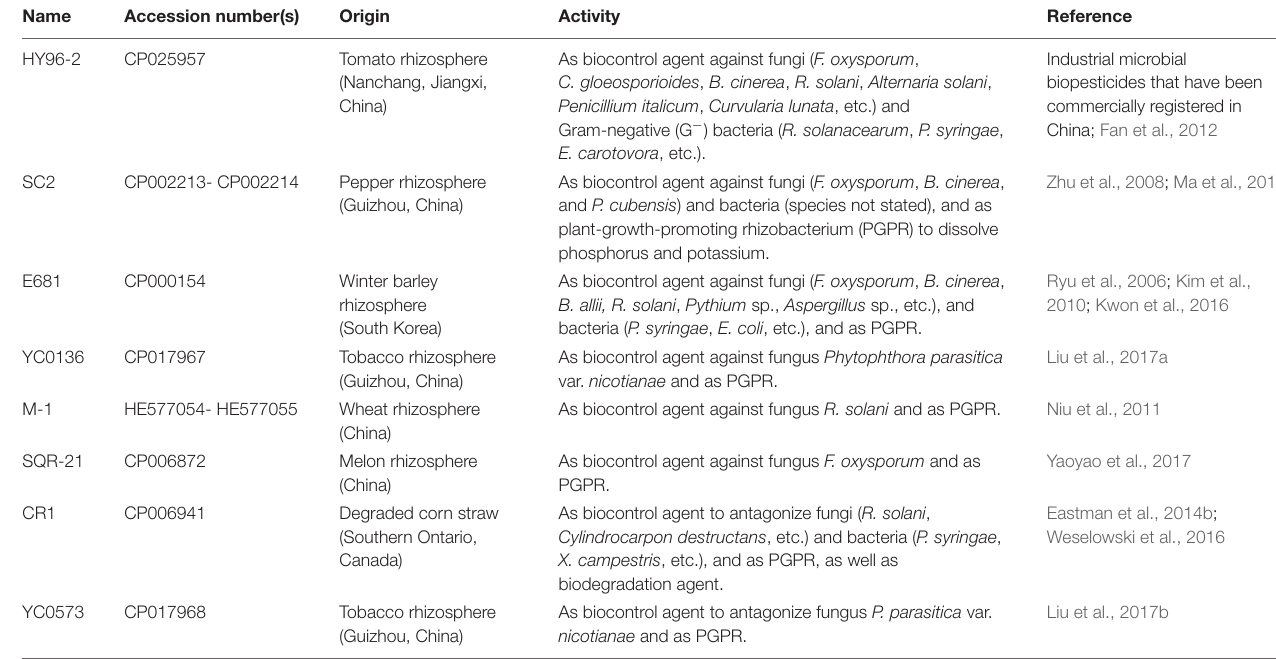
TABLE 1 | Sources and functions of the studied P. polymyxa strains (the complete genomes of which have been